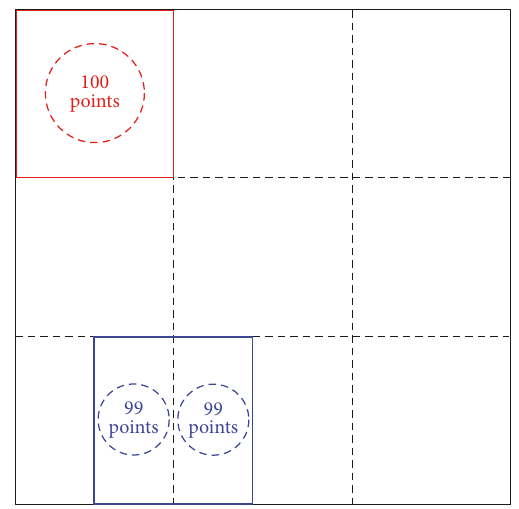
Figure 1: The base cube is colored red; the global optimum is blue. There is no way to move from the red cube to the blue one without losing touch with the base